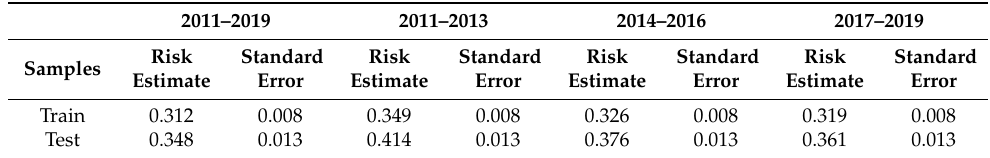
Table 6. Risk estimates for random forest models.